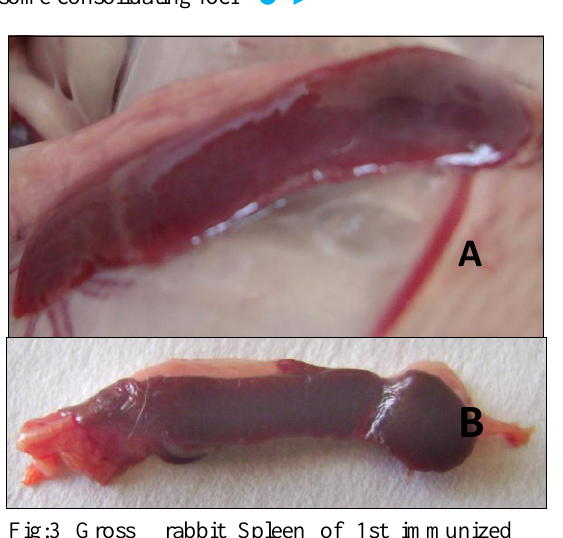
Fig:3 Gross rabbit Spleen of 1st immunized group at 20 days post challenge show severe enlargement (splenomegaly) A when compared to the control group B .